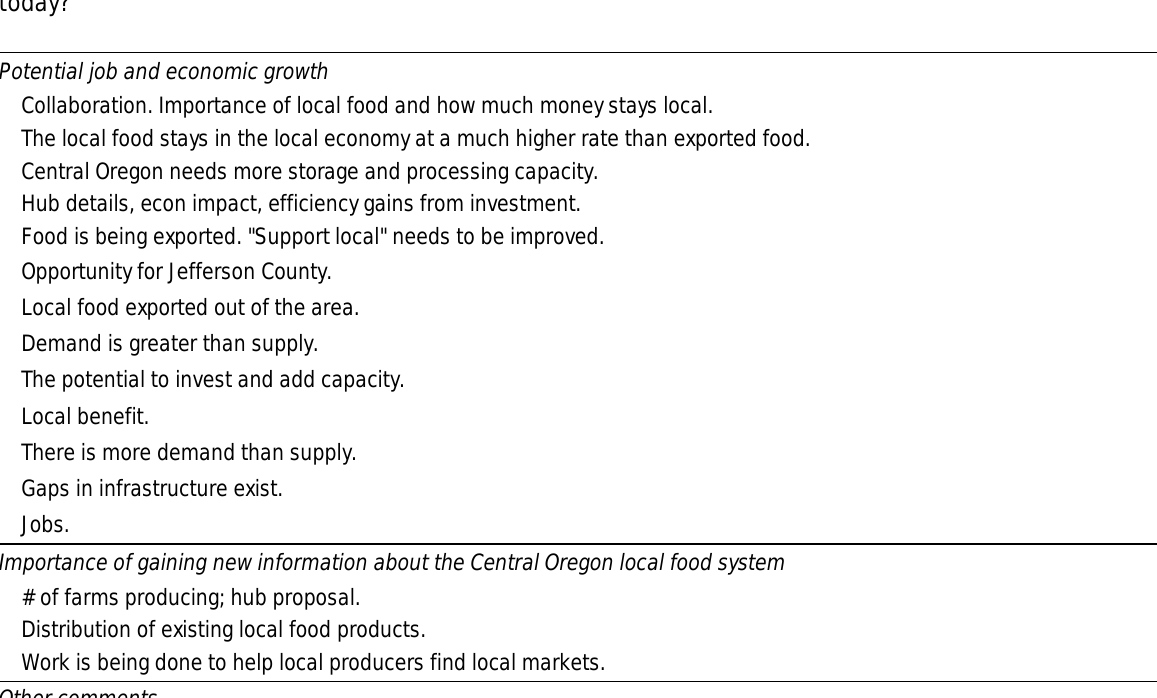
Table 2. Responses to the Open-ended Survey Question, “What was the most important thing you heard